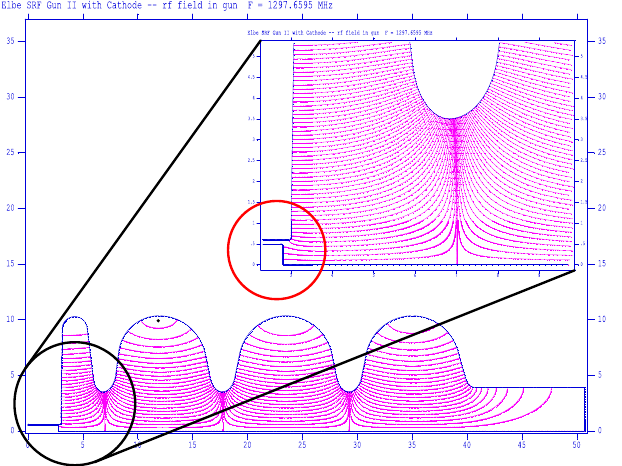
FIG. 2. Example of the transverse electrical field lines affecting the cathode tip. In the indicated area the effect of rf focusing becomes visible, as the field lines indicate the additional focus toward the central gun axis for a retracted cathode.